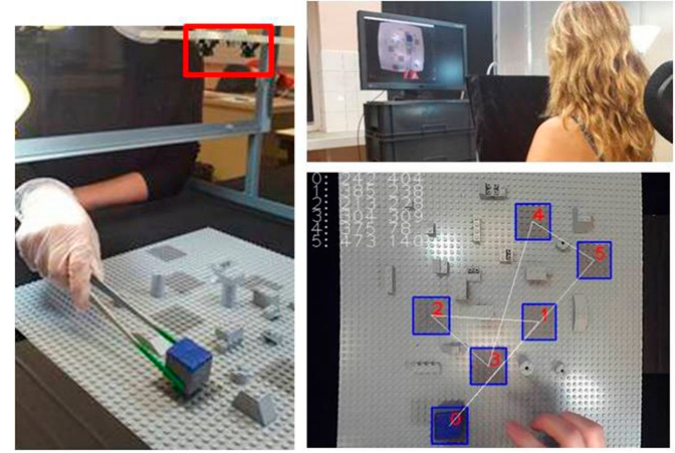
Figure 1. Snapshot views of critical parts of the experimental simulator. One or two cameras (highlighted by the red square in the image on the left) produced the 2D/3D screen views of the action field on the screen ahead of the trainee ( top image on the right ). Trainees practiced in sessions, with varying 2D/3D image views and monitor positions, to learn a five step pick and place task that involved placing a small blue foam cube as precisely as possible, using a forceps-like tool, on the center of five target areas in a specific order ( bottom image on the left ). Precision data in terms of “off-target” scores (in pixels) were computed using system coordinates relative to the target centers (in pixels) and surface-position coordinates relative to the blue foam cube (in pixels), tracked by the system ( bottom image on the right ).